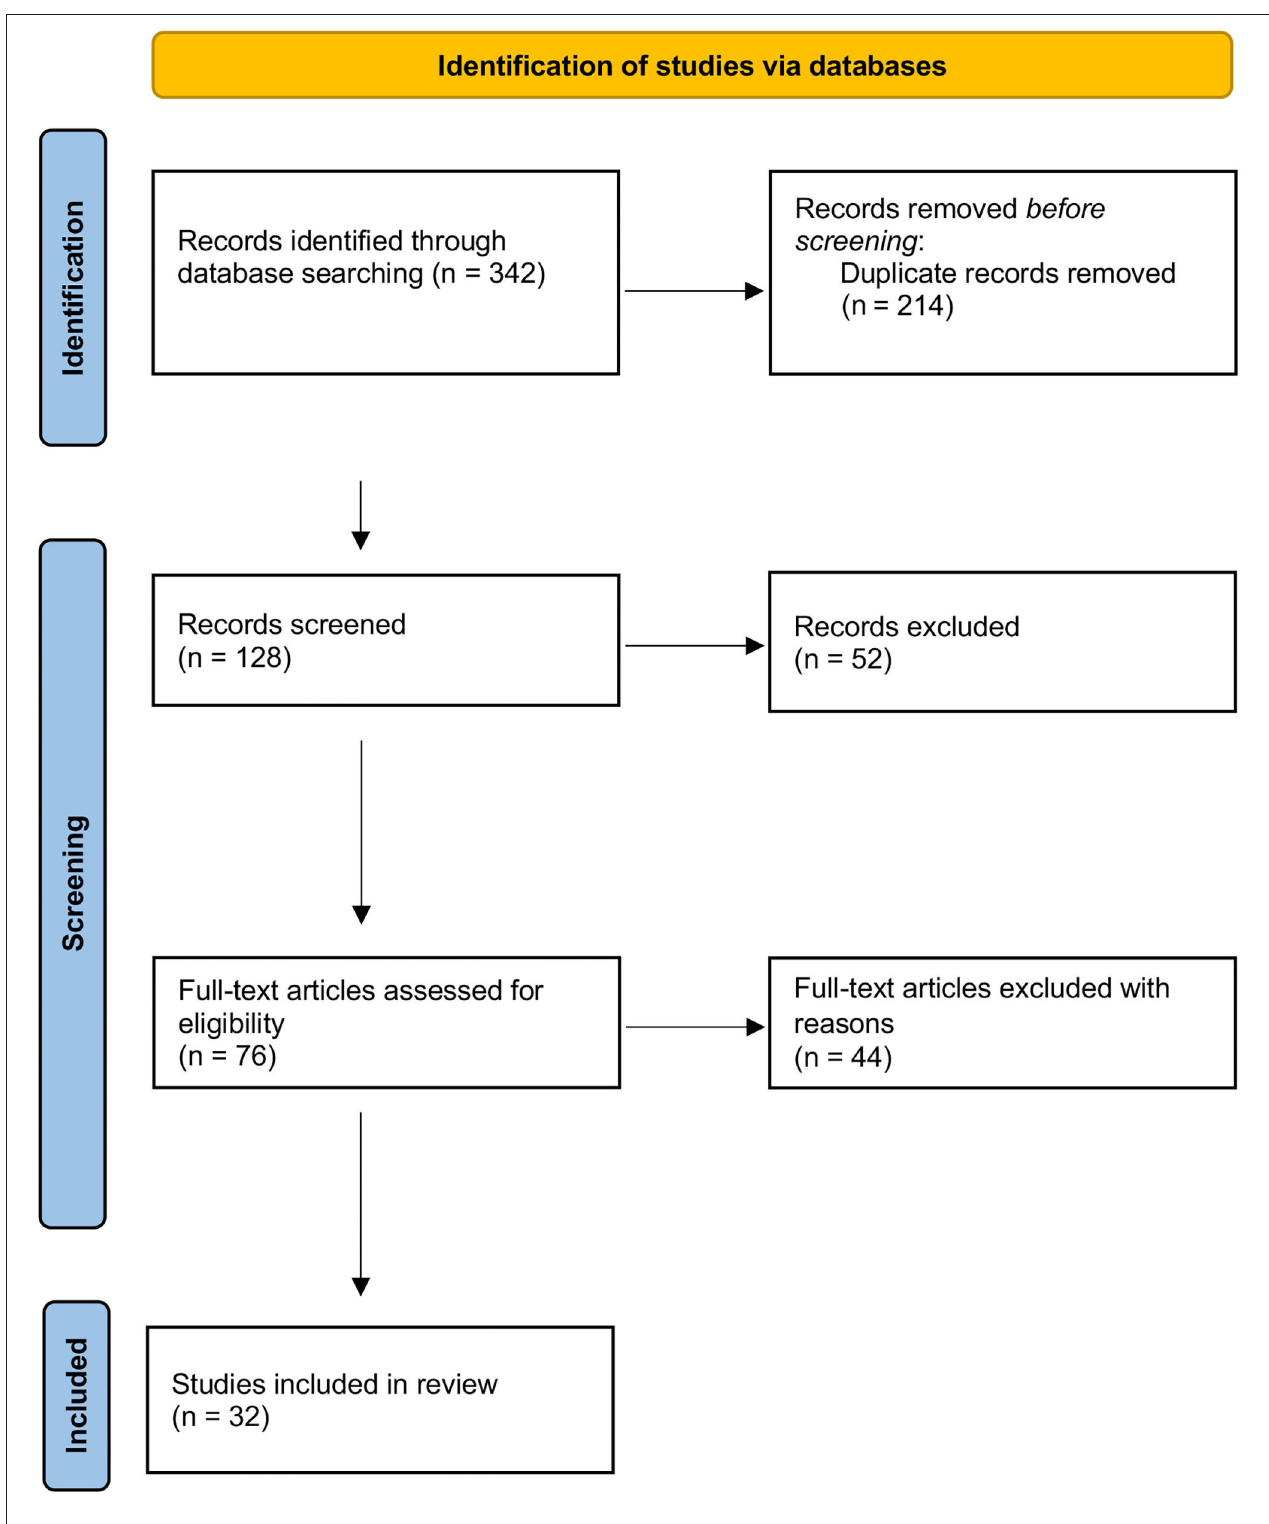
FIGURE 1 | PRISMA Flow Diagram of search results. From Page et al. (23). For more information, visit: http://www.prisma-statement.org/